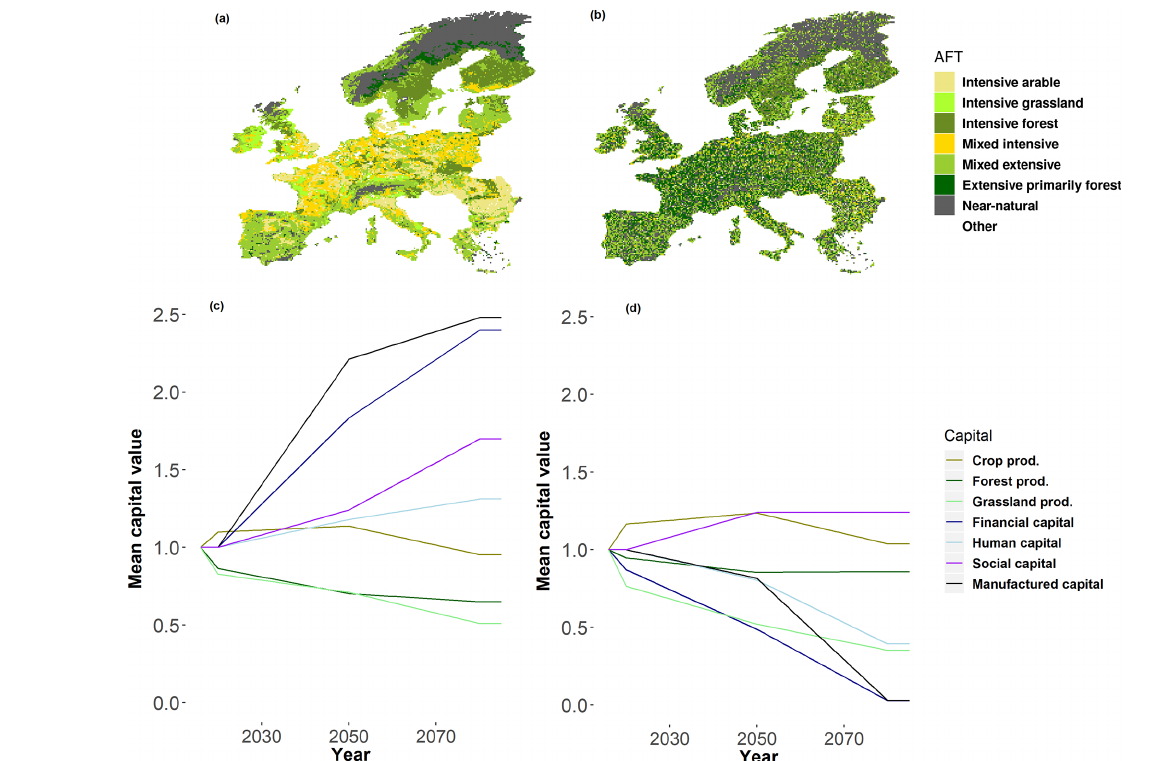
Figure 1. Maps of simulated land cover in 2086 under the RCP4.5–SSP1 scenario combination (a) and the RCP4.5–SSP3 scenario com- bination (b) , showing the two extremes of modelled outcomes across the simulated scenarios. These extremes are driven by the radically different socio-economic capital levels within the two scenarios ( c, d ; capitals shown as mean values normalised by their initial mean value). Changes in capital trends occur due to their interpolation between discrete IAP data